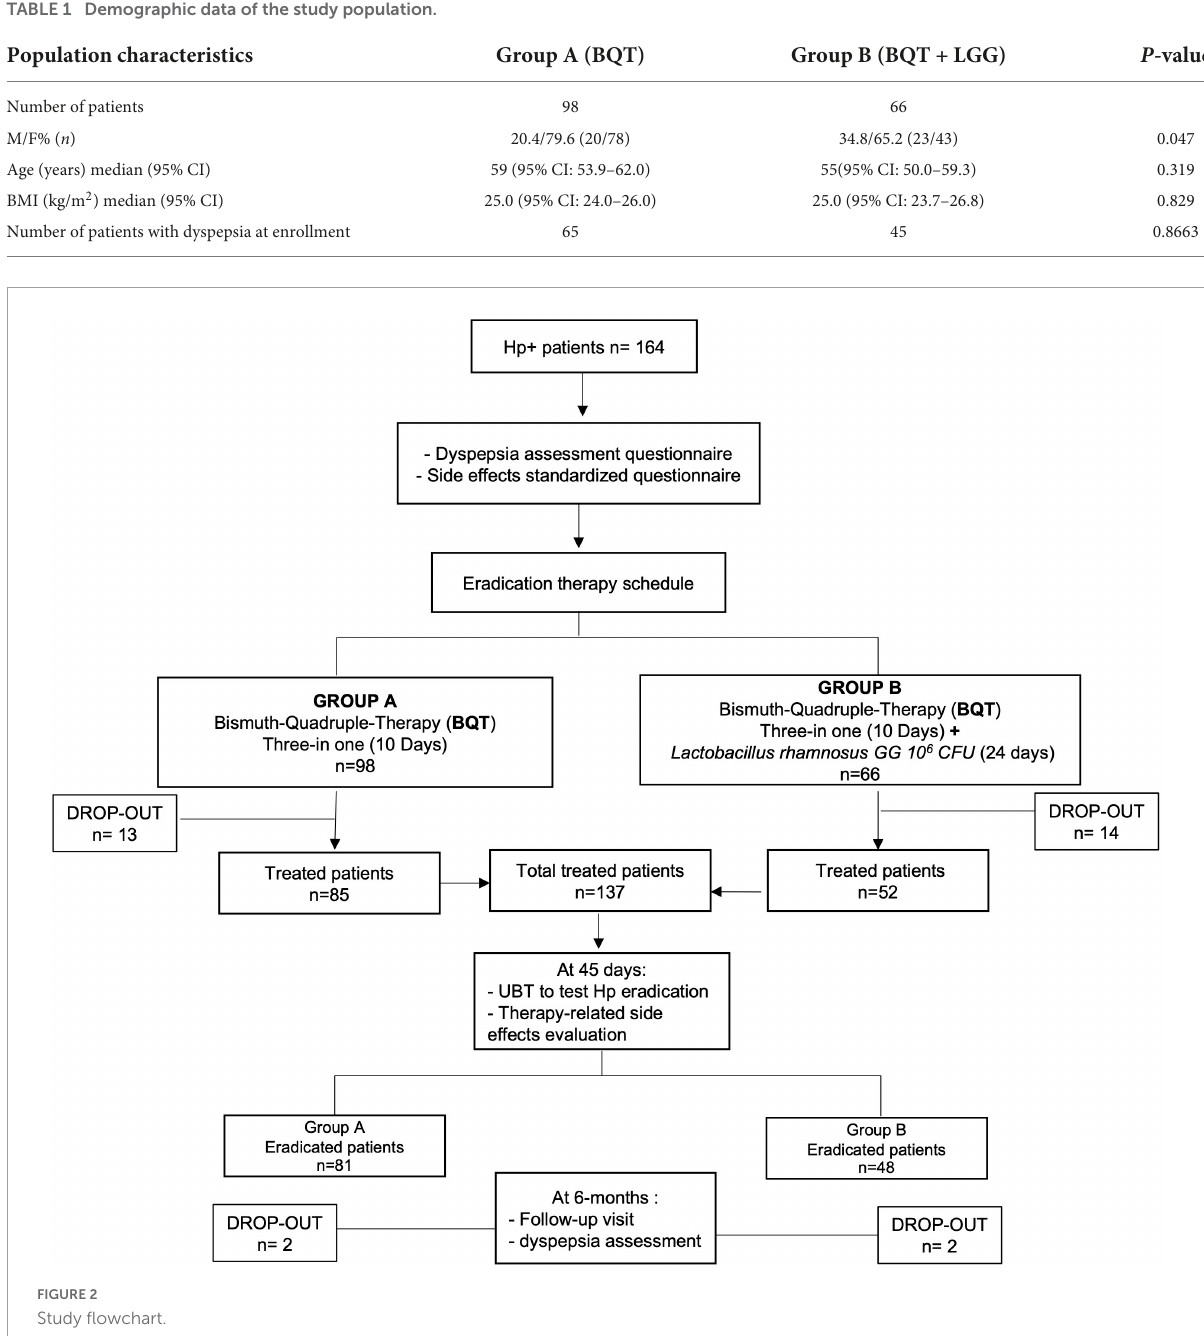
TABLE 1 Demographic data of the study population.